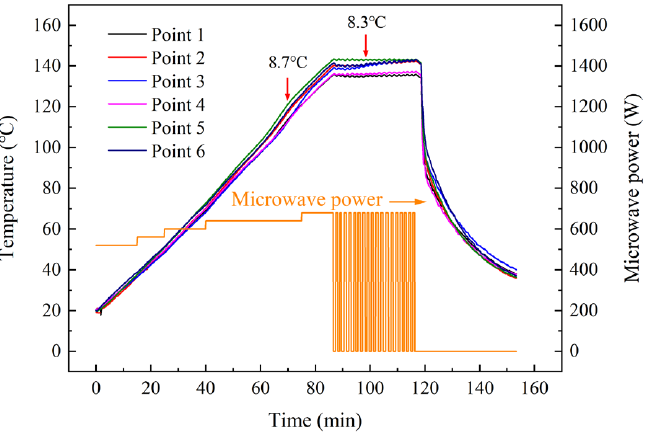
Figure 4. Temperature characteristics of the unidirectional laminate by microwave heating.